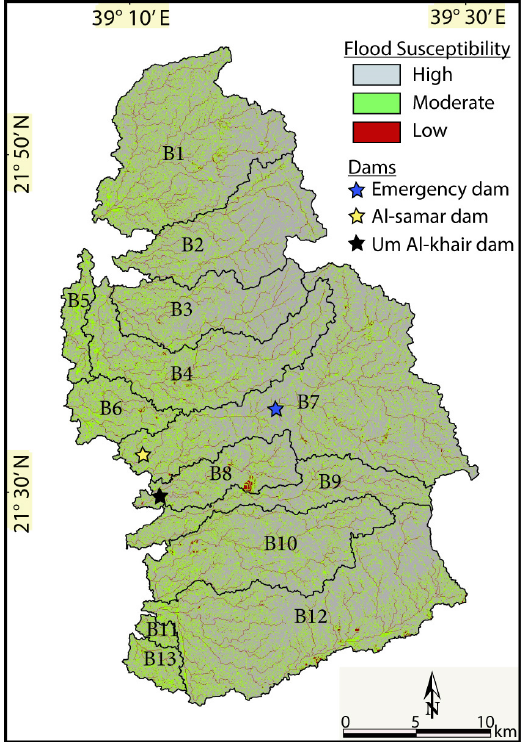
Figure 8. Flash flood susceptibility map of all the parts in each basin.